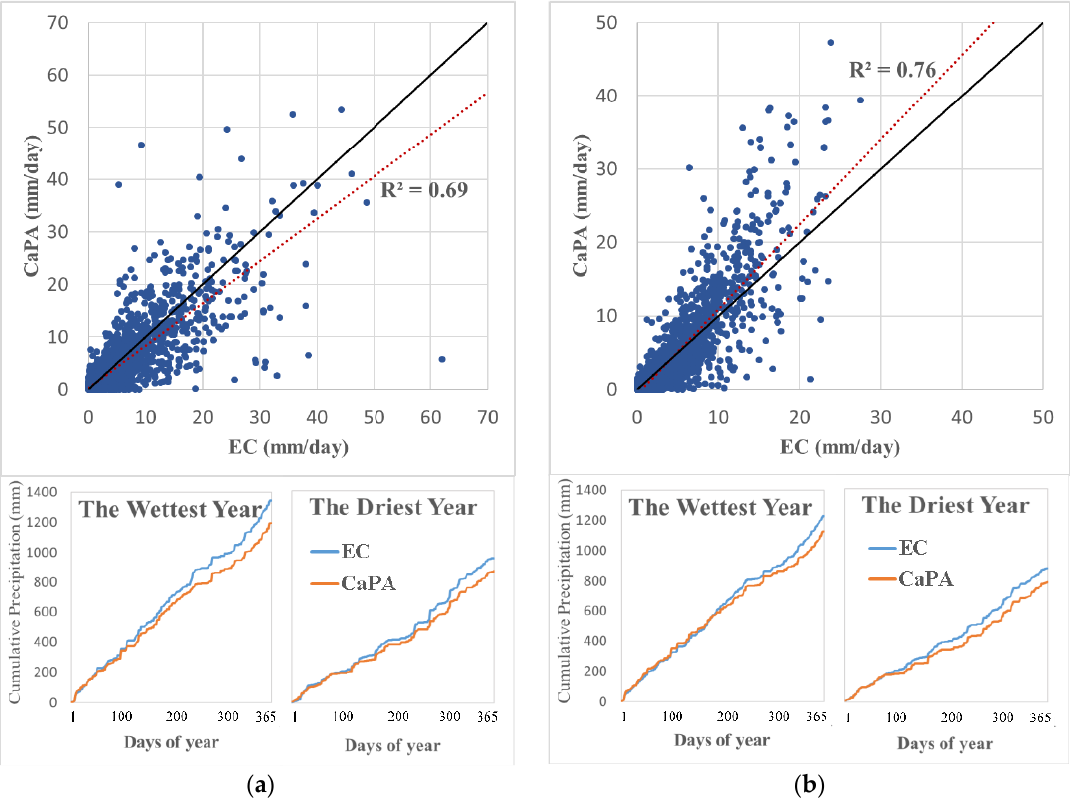
Figure 3. The scatter plots of the mean areal interpolated Environment Canada (EC) and Canadian Precipitation Analysis (CaPA) data and their corresponding cumulative precipitation of the driest and wettest years during the period 2006 – 2015 for both the ( a ) Big East River and ( b ) Black River watersheds.